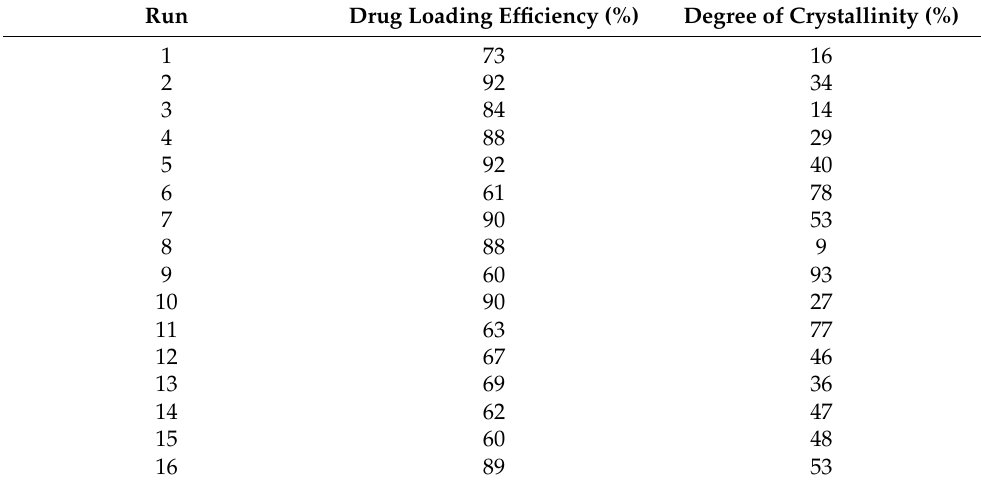
Table 2. Results from the DoE